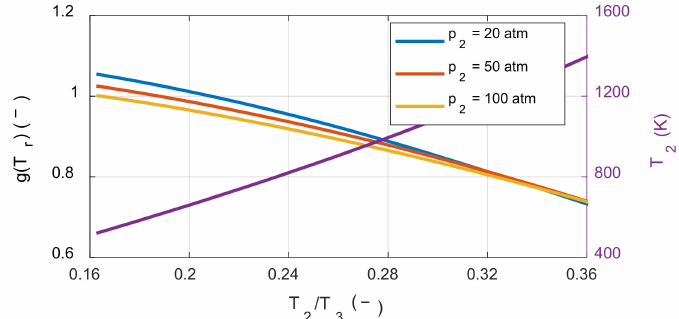
Figure 7. The e ff ect of the temperature ratio and pressure before combustion on the net work sensitivity of the compression ratio.